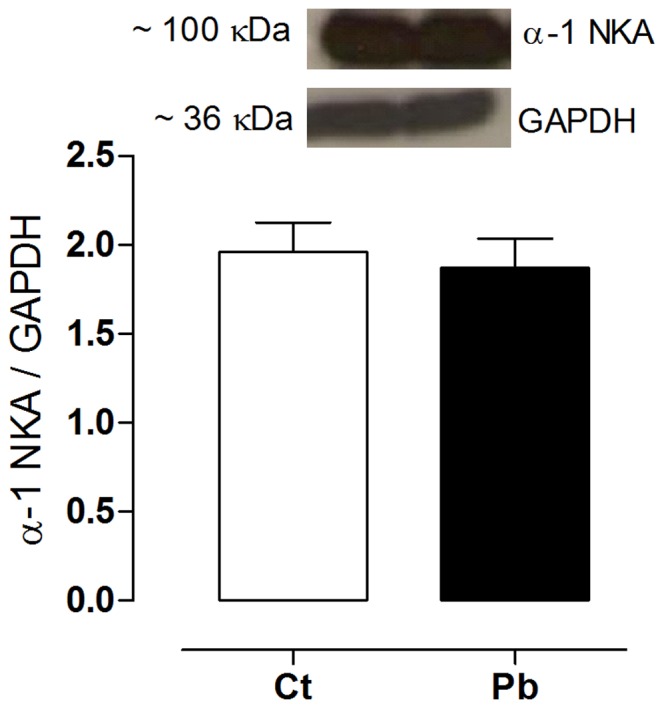
Protein expression levels of the ventricular α-1 Na+, K+-ATPase subunit.Bands that are representative of the Western blots of the expression of α-1 Na+, K+-ATPase subunit and GAPDH (Glyceraldehyde 3-phosphate dehydrogenase) are presented at the top of the figure. Results are expressed as the ratio between the area and density of α-1 Na+, K+-ATPase subunit and GAPDH in the control (Ct) and lead treated (Pb) groups. Number of animals = 7 for each group. p>0.05, Ct vs Pb, Student t-test.